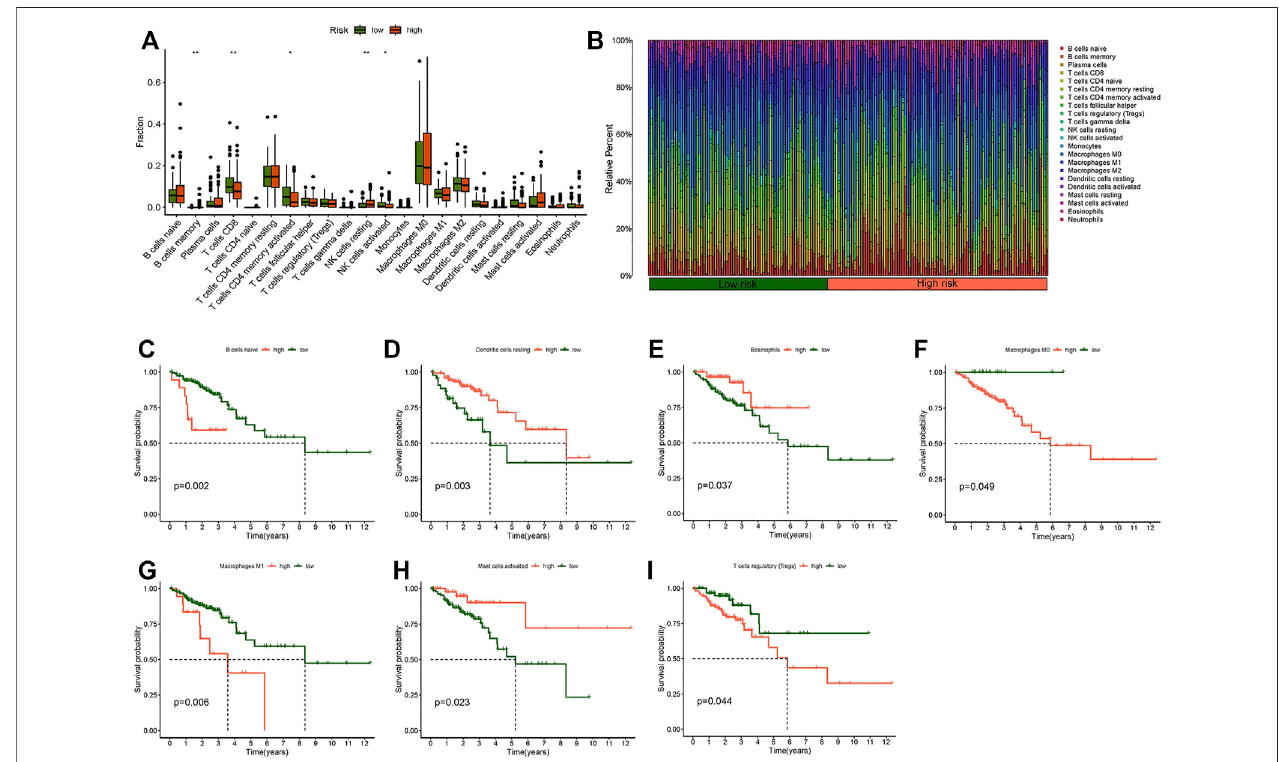
FIGURE 8 | Immune cell in fi ltration analysis. (A) Boxplot of difference analysis of immune cells in the high- and low-risk group. (B) Relative percent of different immune cells in the high- and low-risk group. (C) Kaplan – Meier survival analysis in naive B cells. (D) Kaplan – Meier survival analysis in resting dendritic cells. (E) Kaplan- Meier survival analysis in eosinophils. (F) Kaplan – Meier survival analysis in M0 macrophages. (G) Kaplan – Meier survival analysis in M1 macrophages. (H) Kaplan – Meier survival analysis in activated mast cells. (I) Kaplan – Meier survival analysis in regulatory T cells (Tregs). * p < 0.05, ** p < 0.01, *** p <